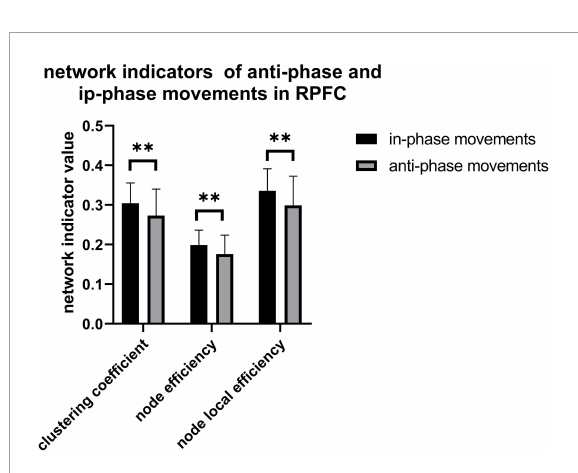
FIGURE7 The activation region ( t = 0.05) under general linear model in conditions of LCRC, LWRW, LCRW, and LWRC. LCRC, left hand clockwise and right hand clockwise. LWRW, left hand counterclockwise and right hand counterclockwise. LCRW, left hand clockwise and right hand counterclockwise. LWRC, left hand counterclockwise and right hand